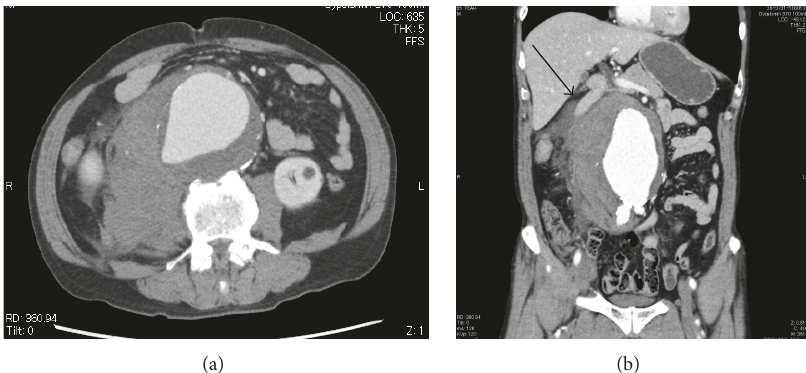
Figure 1: (a) Enhanced computed tomography revealing a ruptured aortic aneurysm measuring 7.9 × 7.6 cm in diameter in the right retroperitoneal region. (b) The inferior vena cava is compressed by a hematoma (black arrow).